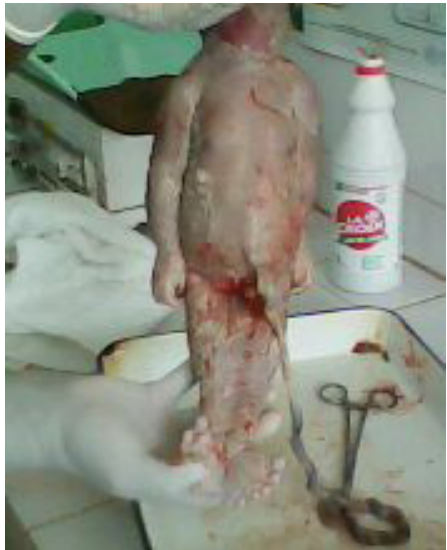
Figure 1. Complete morphological view showing distended abdomen, fused lower limbs and maceration around the